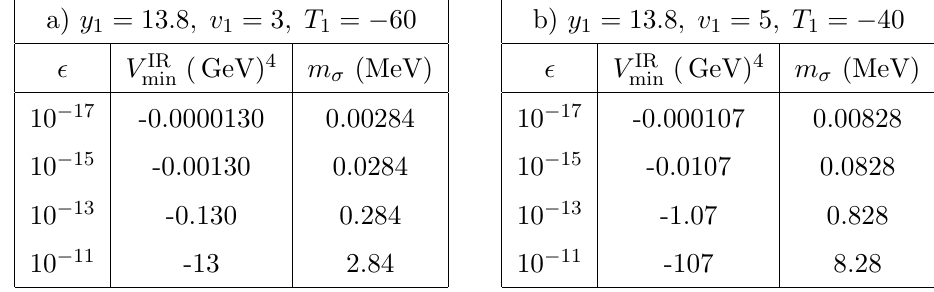
Table 1. The contribution to the vacuum energy and the radion mass for each benchmark pa- rameter set, with (cid:11) =1. Di(cid:11)erent values can be obtained by rescaling the values by (cid:11) . The tuning between UV and IR value of the (cid:12)eld (cid:30) given by v 0 =v 1 , is equal to 0.095 for a) and 0.62 for